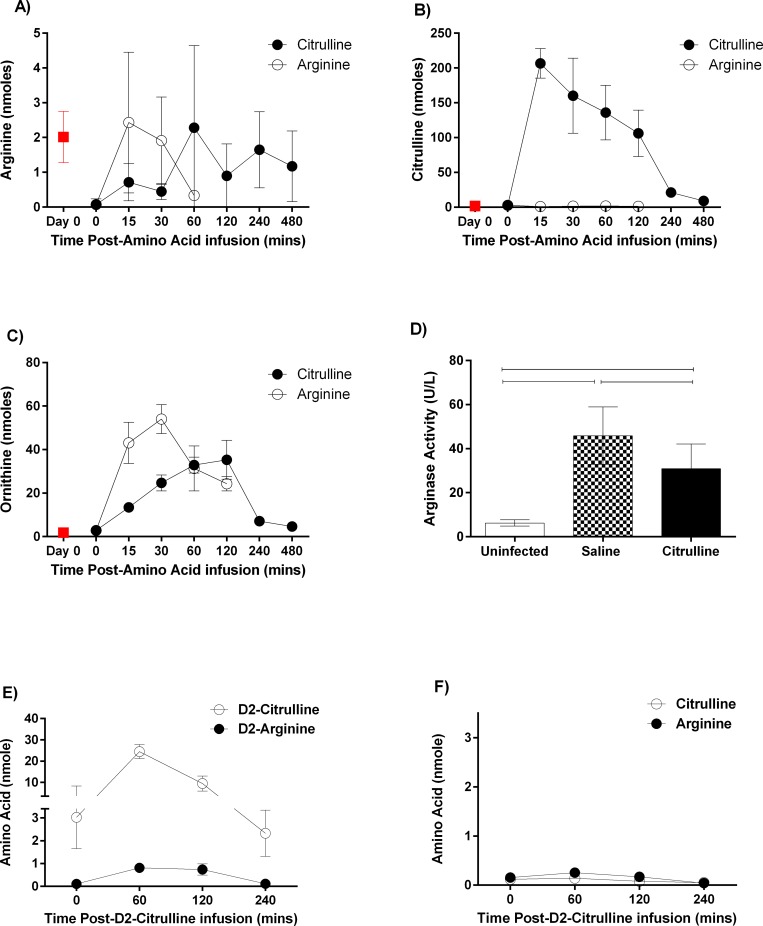
Citrulline is converted to arginine on day 5 of eCM restoring plasma arginine levels to uninfected levels.Mice were injected i.v. with PbA on day 0 PI. A-C: On day 5PI (just prior to eCM on day 6PI), mice were injected ip with equimolar citrulline or arginine (430 mM) at time 0 and then plasma from n = 3 mice was obtained at the selected timepoints. The plasma levels of (A) arginine, (B) citrulline, and (C) ornithine were measured by HPLC. Uninfected mice (n = 3) were control group. The experiment was repeated. Citrulline; Arginine. D: Mice were injected twice daily from day 1 PI with citrulline or saline (vehicle); uninfected, untreated mice were used as controls. On day 6PI, plasma was collected, and arginase activity was measure using the arginase activity assay (Millipore-Sigma, St-Louis,MO). p<0.05. Repeated i.p injections of arginine elicited pathology in the peritoneal cavity and were not performed again. This experiment was repeated for citrulline. E, F: Groups (n = 3) of mice were injected with D2-labeled citrulline and the levels of arginine and citrulline assessed by mass spectrometry at the selected timepoints. (E) D2-Citrulline; D2-Arginine; (F) Citrulline; Arginine.